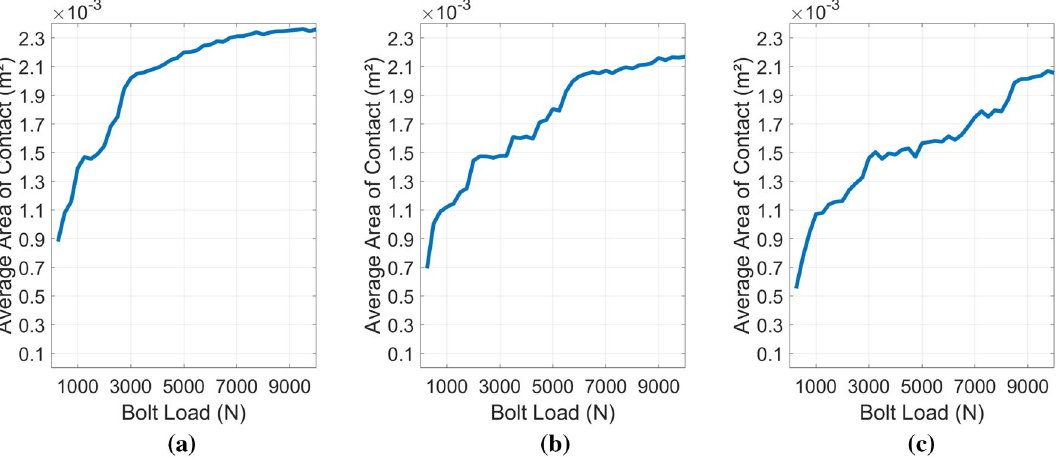
Fig. 8 The average area of contact ( m 2 ) over 0.05 s with a 500 N, b 1000 N and c 1500 N excitation amplitude, the second mode of